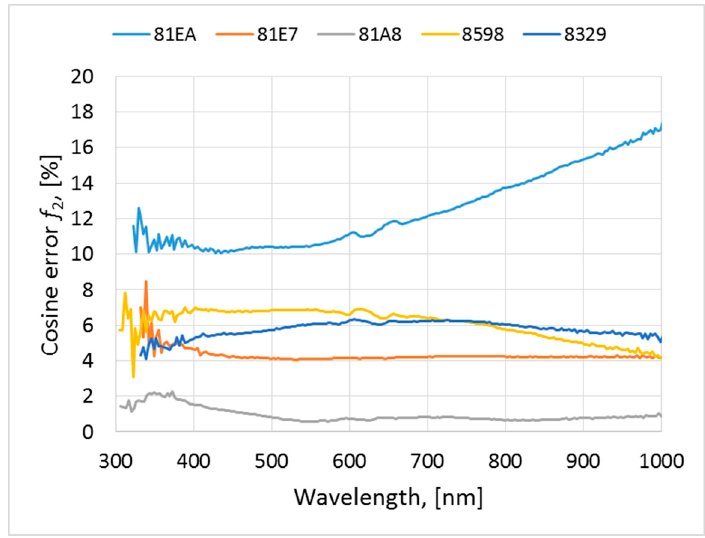
Figure 15. Integrated cosine error of the five RAMSES radiometers.